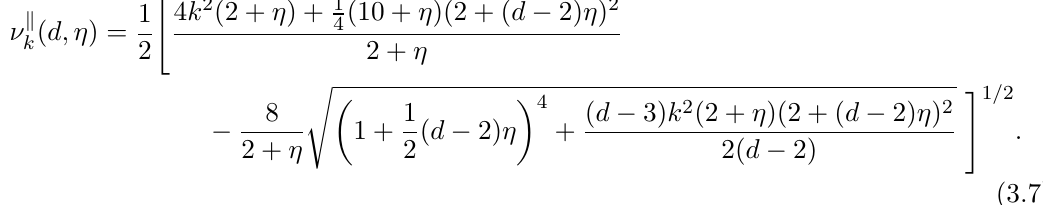
Figure 5. The exponent (cid:23) ? smeared Fermi surface as opposed to a Fermi